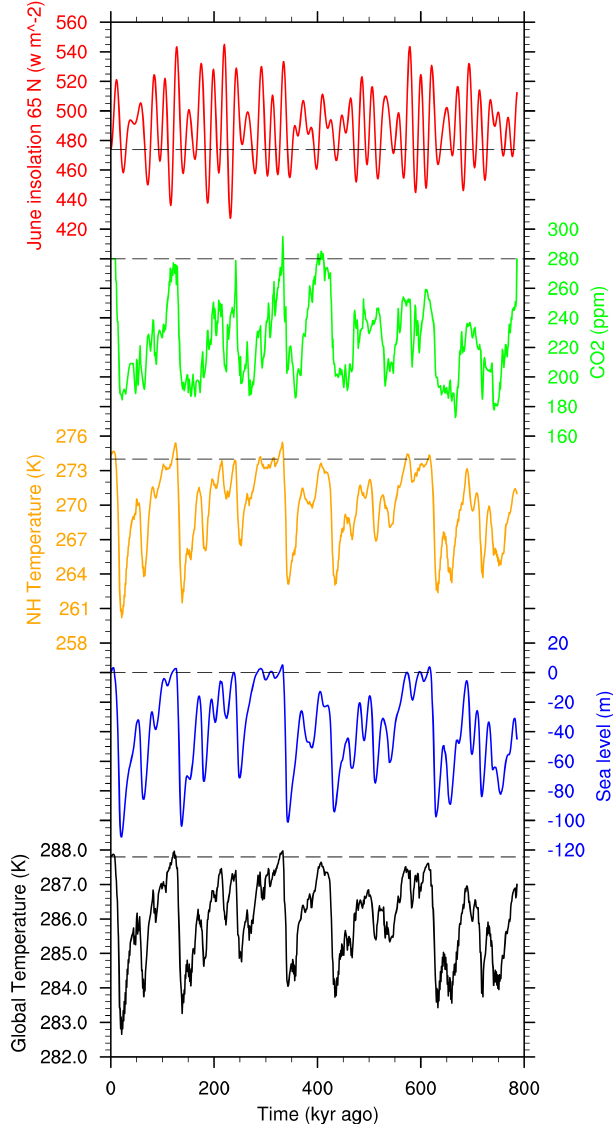
Figure 3. Insolation (Laskar et al., 2004, red), CO 2 (Jouzel et al., 2007, green) input, modelled reference NH temperature (orange), sea level relative to PD (blue), and global temperature